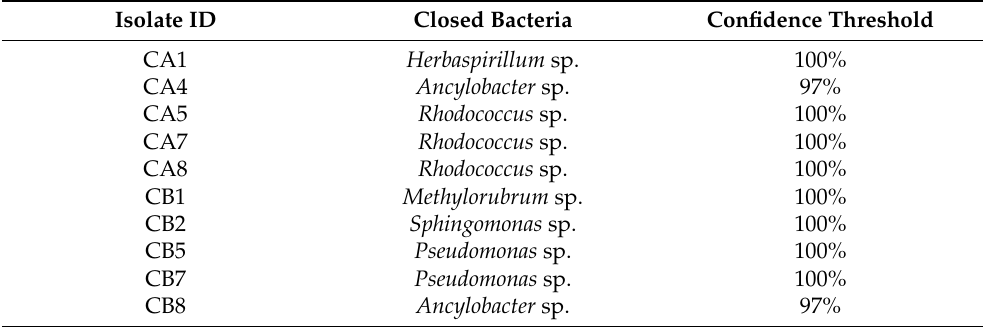
Table 1. Taxonomy of the obtained isolate. Assignment according to the Ribosomal Database Project